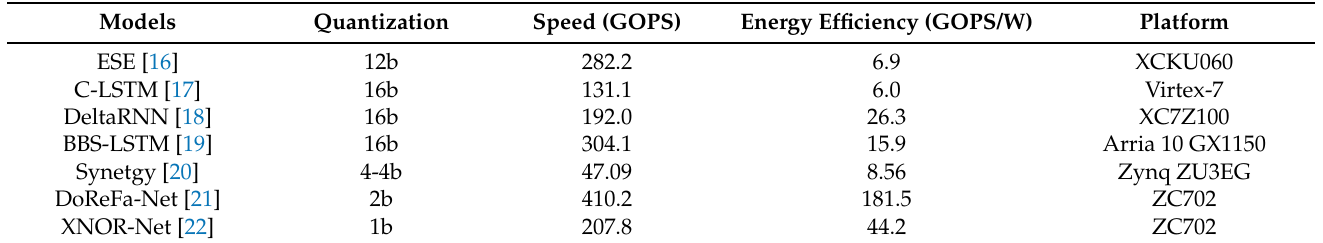
Table 1. Performance comparison of state-of-the-art FPGA-based accelerator designs.